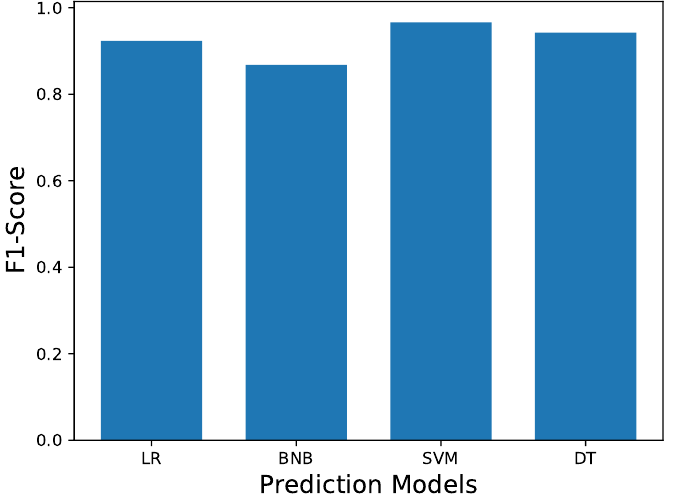
Figure 3. F1-scores of the proposed ML algorithms for the potential COVID-19 carrier detection. LR refers to linear regression, BNB refers to Bernoulli naive Bayes, SVM refers to support vector machines, and DT refers to decision